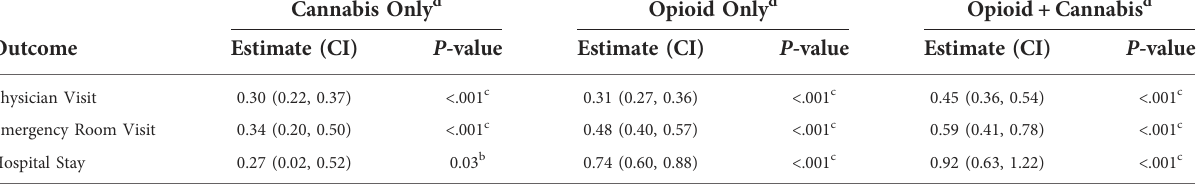
TABLE 3 Differences in health utilization by cohort a